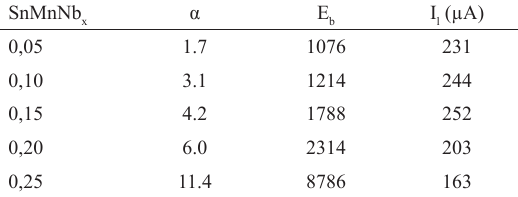
Table 2. Varistor characteristics obtained from the dc